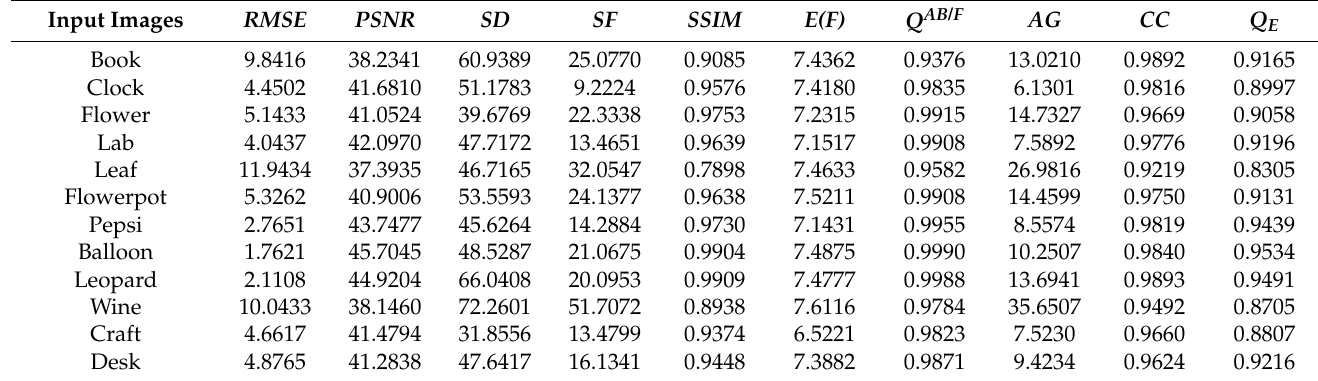
Table 1. For certain trailed images, the outcomes of the proposed method.